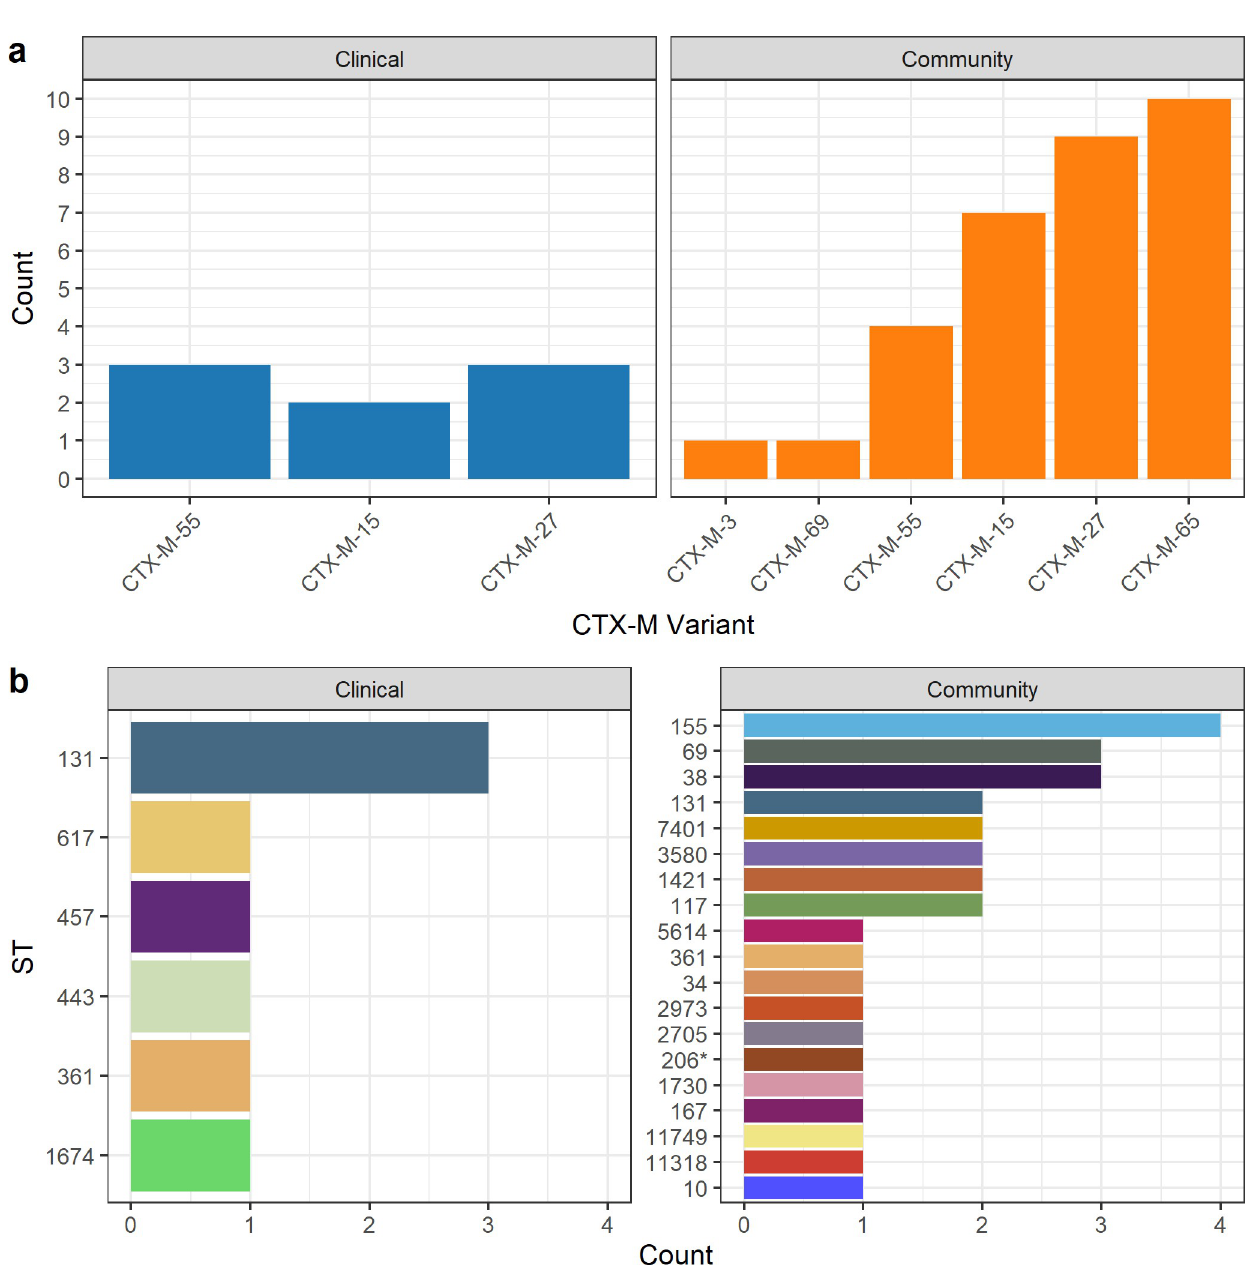
Fig 2. Distribution of bla CTX-M variant (a) and MLST (b) carried by ESBL-producing E . coli isolated from Segamat clinical and community samples. MLST was typed using the Achtman scheme. isolated from patients in the same district. We report for the first time the association between ESBL-EC isolated from the asymptomatic community and a co-located healthcare setting in Malaysia. Isolates from both settings shared similar resistance genes, susceptibility profiles and carried plasmid groups, suggesting that horizontal gene transfer is a dominant dissemination route for ESBL and other antibiotic resistance genes in the region. Additionally, we believe this to be the first report of ESBL colonization among community dwellers in Malaysia.